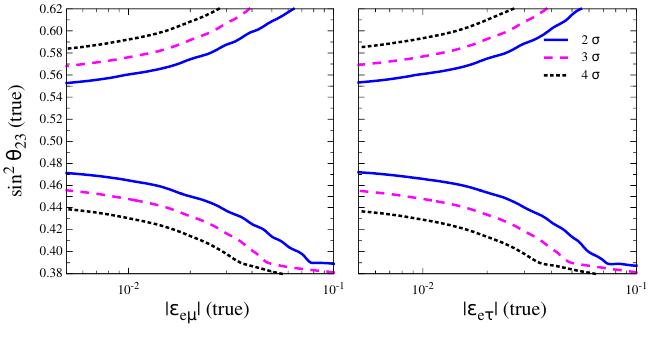
Figure 19.3: Octant of θ discovery reach as a function of | (cid:34) | (true) assuming NH 23 as true choice. The solid blue, dashed magenta, and dotted black curves depict the 2 σ , 3 σ , and 4 σ confidence levels (1 d.o.f.). We have fixed the | (cid:34) | both in data and theory. In both the panel we have marginalized over the hierarchies, θ octant), and δ (both in data and theory). In addition, the NSI CP-phases φ φ have been marginalized away both in data and theory in the left and right panel e τ respectively. This figure has been taken from [ 35 ]